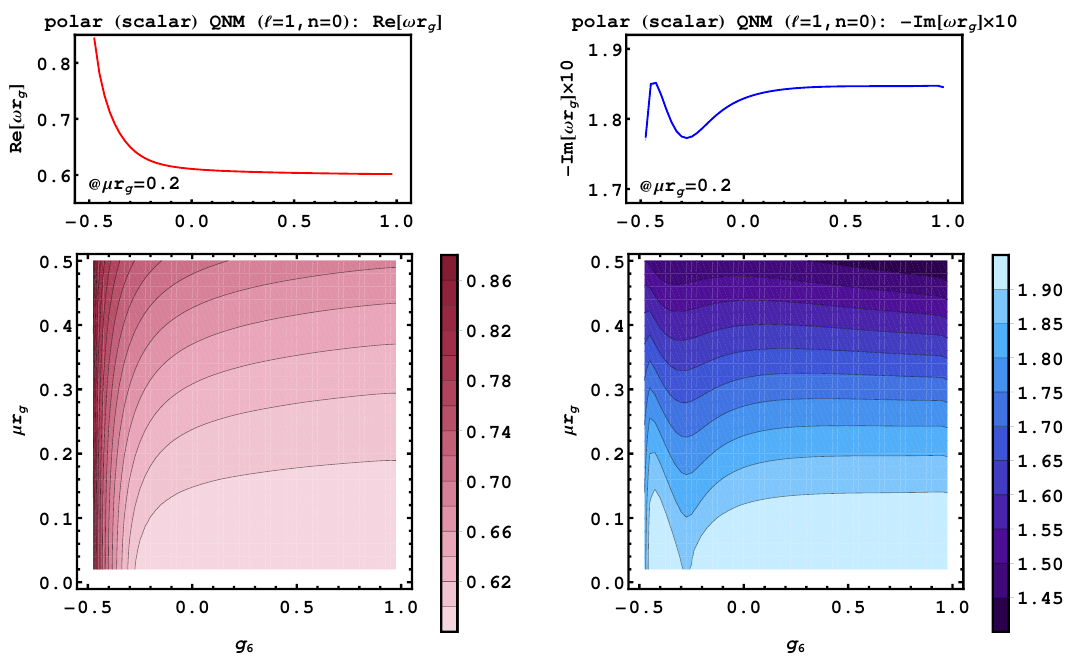
Figure 3 . Polar (scalar): real (left-hand panels) and imaginary (right-hand panels) part of the fundamental ( n = 0 ) first multipole ( ‘ = 1 ) QNM in the g 6 – µ plane (lower panels) and as a function of g 6 at µ r g = 0 . 2